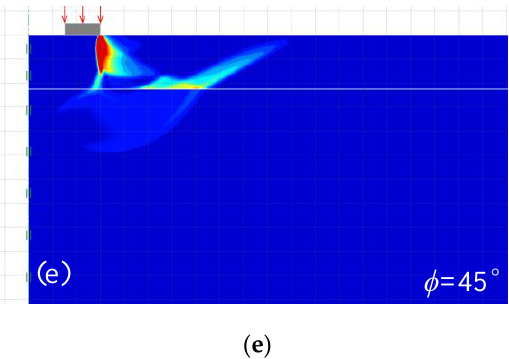
Figure 9. Upper bound collapse mechanisms for R i / R 0 =0.5, c u /( γR 0 )=1, H / R 0 =0.75 with (a) φ =25°, (b) φ =30°, (c) φ =35°, (d) φ =40°, and (e) φ =45°.